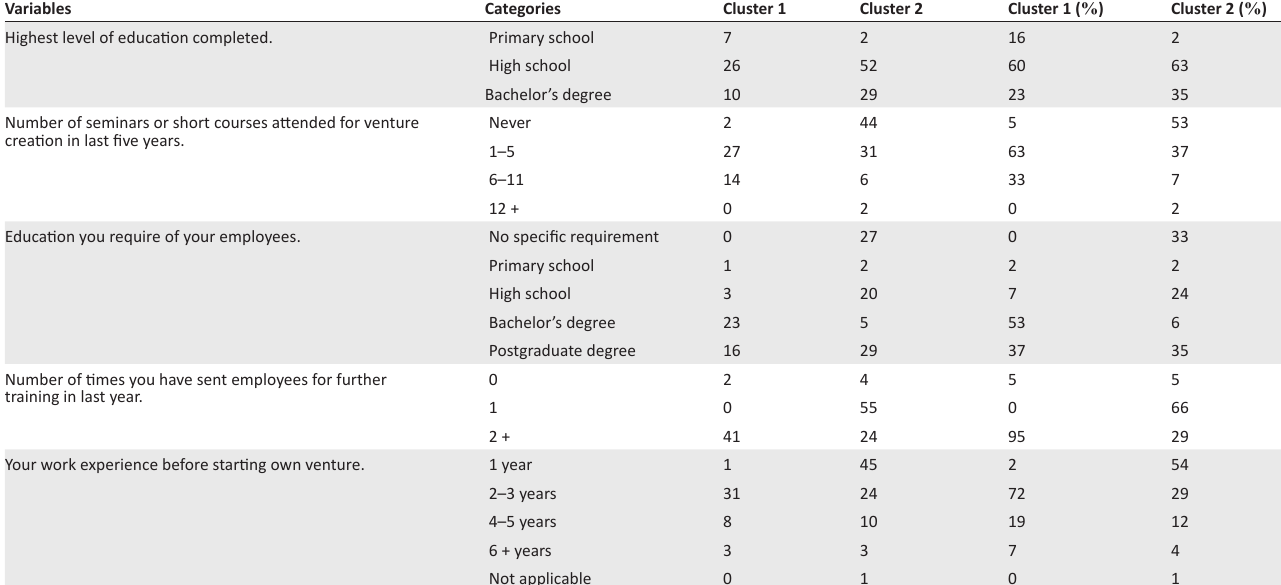
TABLE 4: Performance indicators. Variable Categories Employee growth – number of staff increased in last three years.